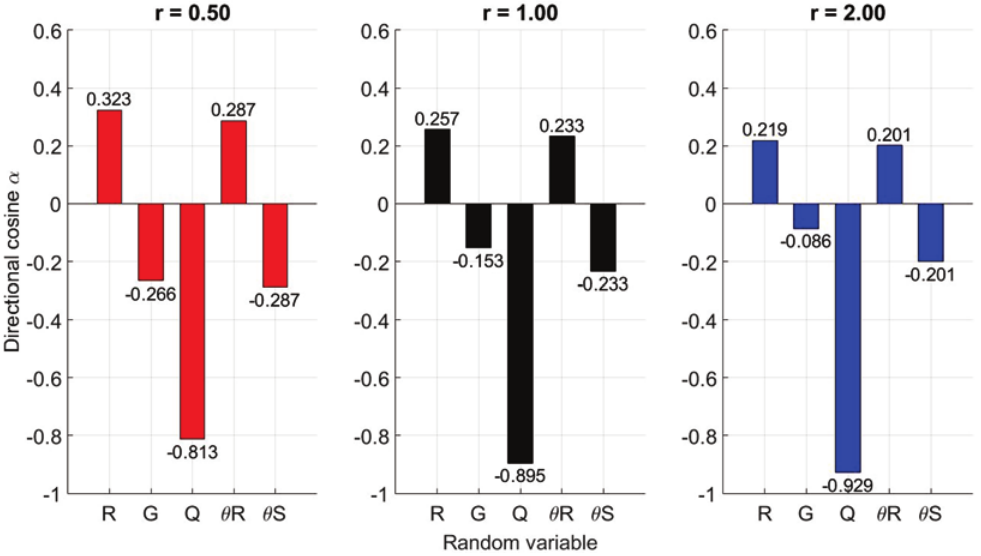
Figure 6.9 Directional cosines obtained via FORM for the beam V-25-40-r-15